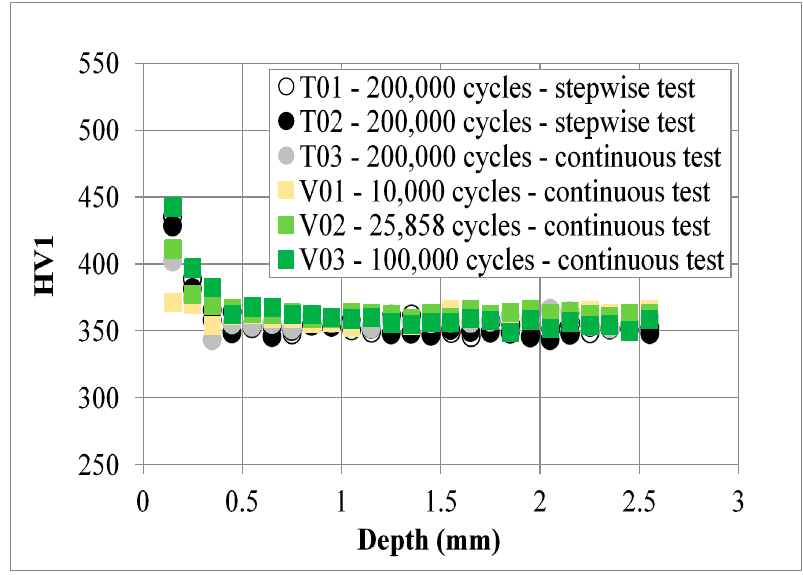
Figure 13. Vickers hardness as a function of the depth on the cross-section of the wheel discs for validation tests and comparison with training tests.